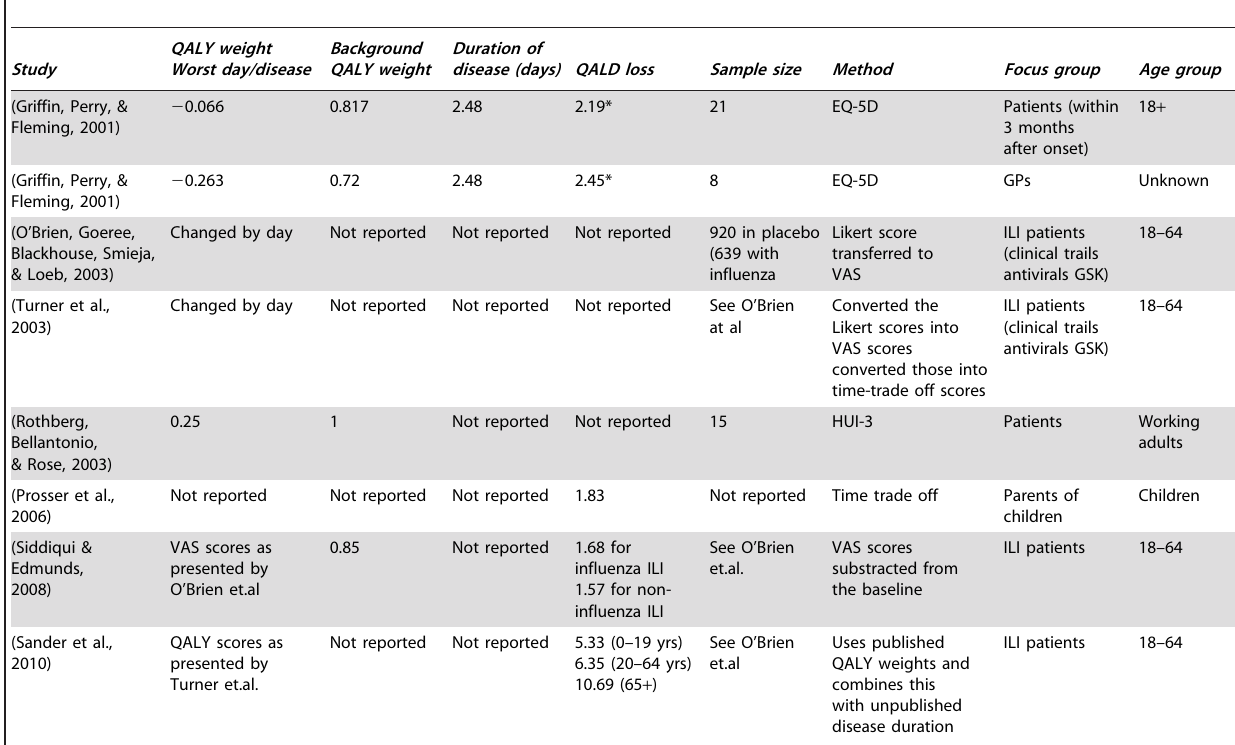
Table 5. Overview of different published estimates of QALDs lost due to ILI, for sources which presented data or interpretation of that